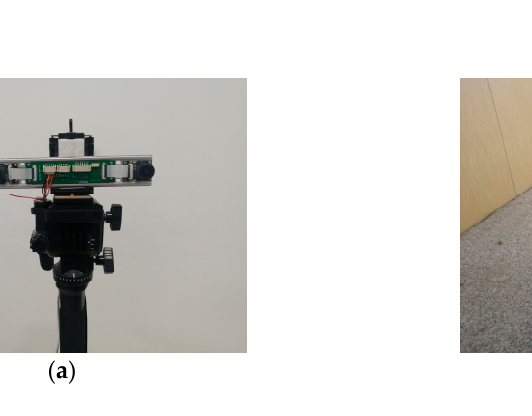
Figure 8. Experiment platform: ( a ) The BSV rig; ( b ) Mobile robot platform. Table 1. Camera intrinsic